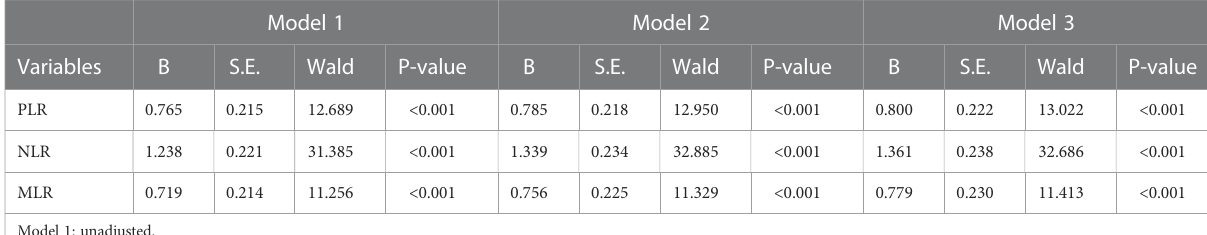
TABLE 4 Logistic regression analysis of PLR, NLR, and MLR and the risk of arterial